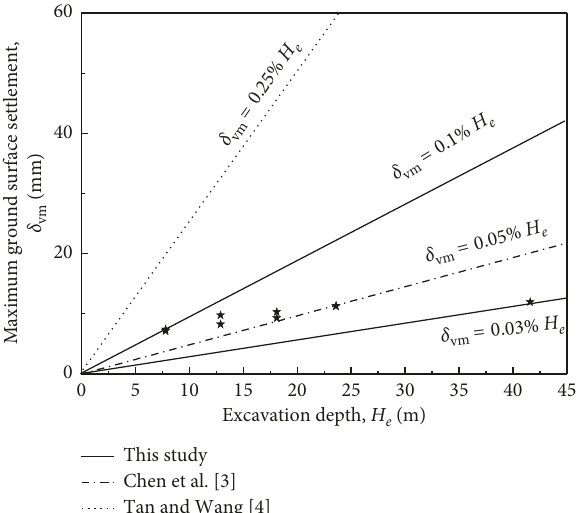
Figure 15: Maximum ground settlement δ depth H e .